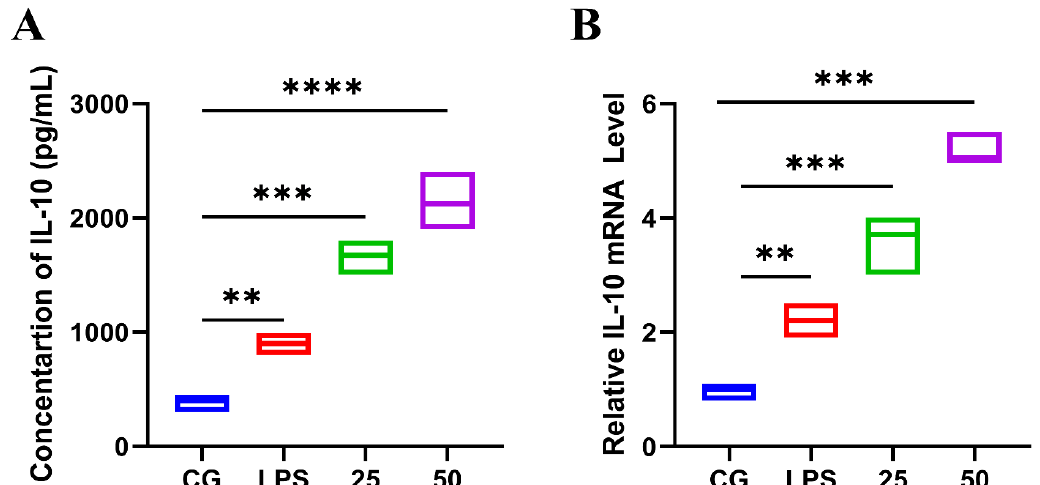
Figure 5. Effects of GnRb1 against LPS-induced production IL-10 concentration. The concentration of ( A ) IL-10 (pg/mL). The relative mRNA expression level of ( B ) IL-10 in uterine tissue. CG represents the control group. LPS reveals the LPS-induced groups. The 25 and 50 are the GnRb1-administrated groups representing 25 mg/kg and 50 mg/kg per animal, respectively. GnRb1 indicates the Ginsenoside Rb1. Data statistics are demonstrated as mean ± S.E.M. The ** p < 0.001 CG versus LPS group, ** p < 0.01, *** p < 0.001, **** p < 0.0001, and ns indicates the nonsignificant difference between CG versus LPS + GnRb1 groups.